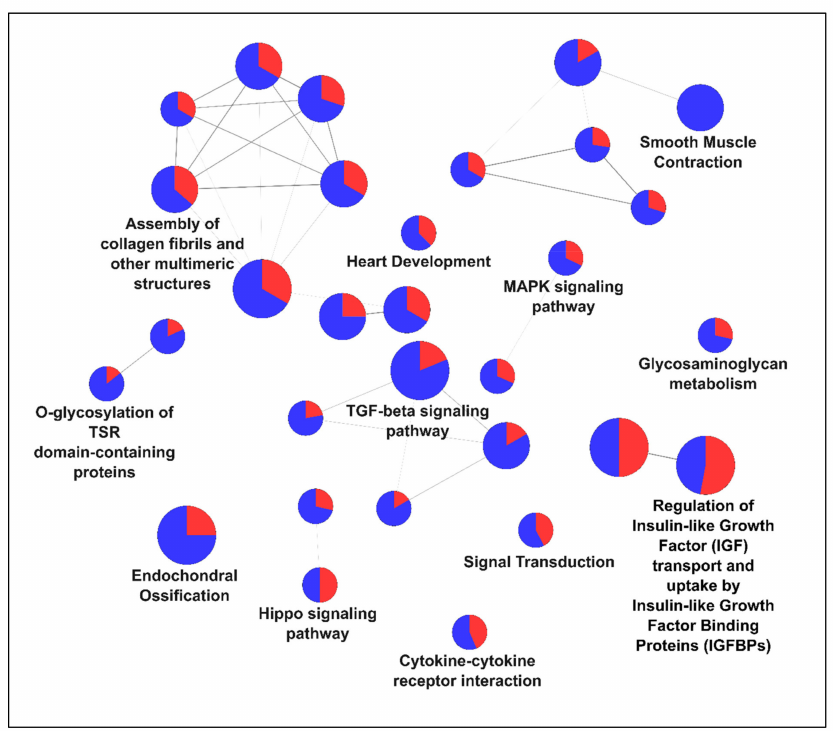
Figure 2. Pathway enrichment analysis of the 350 most up- and downregulated genes using ClueGO (Cytoscape software plugin, [48]. GO/Reactome/WikiPathways/KEGG pathway ([47,49–51]) func- tionally grouped networks with terms indicated as nodes (Benjamini–Hochberg p value < 0.05) linked by their kappa score level ( ≥ 0.4); only the label of the most significant term per group is shown. The size of the node correlates with the term significance. The node color shows the proportion of genes either upregulated (red) or downregulated (blue) associated with the